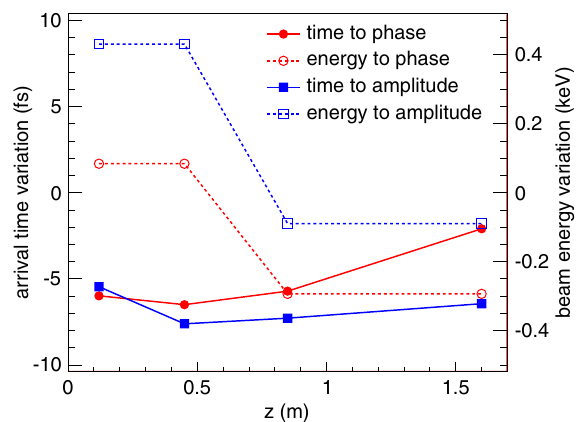
TABLE II. The rf amplitude required at the buncher for lon- gitudinal focusing at the sample for various beam launch phases at the cathode. The rf phases are set to be the same as the nominal phases, (cid:1) 1 (cid:3) and (cid:1) 2 : 8 (cid:3) from the 0-crossing phase at the first and second buncher cavities, respectively. When rf ampli- tude at the buncher is higher, beam arrival time variation produced by rf jitter at the buncher becomes bigger.